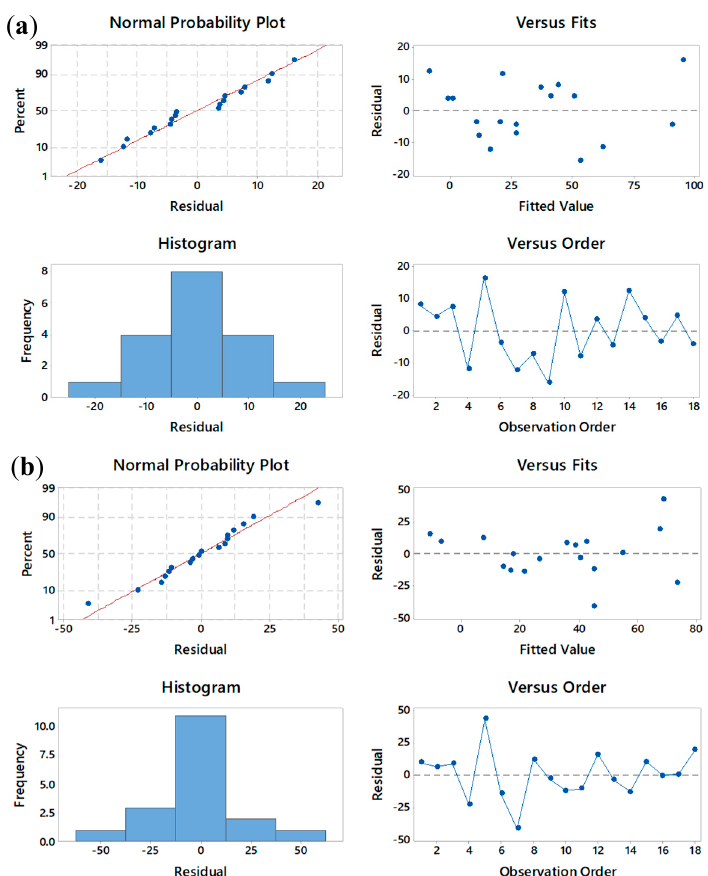
Figure 6. Residual plots for Erosion rate [mg / min] when considering ( a ) all predictors (see Table 7), ( b ) only significant predictors (see Table 8). Table 8. Analysis of variance (ANOVA) after the stepwise regression for the Erosion rate [mg / min], with an indication of the source of variation, degrees of freedom (DF), Adjusted Sum of Squares (Adj SS), F -value, and p -value